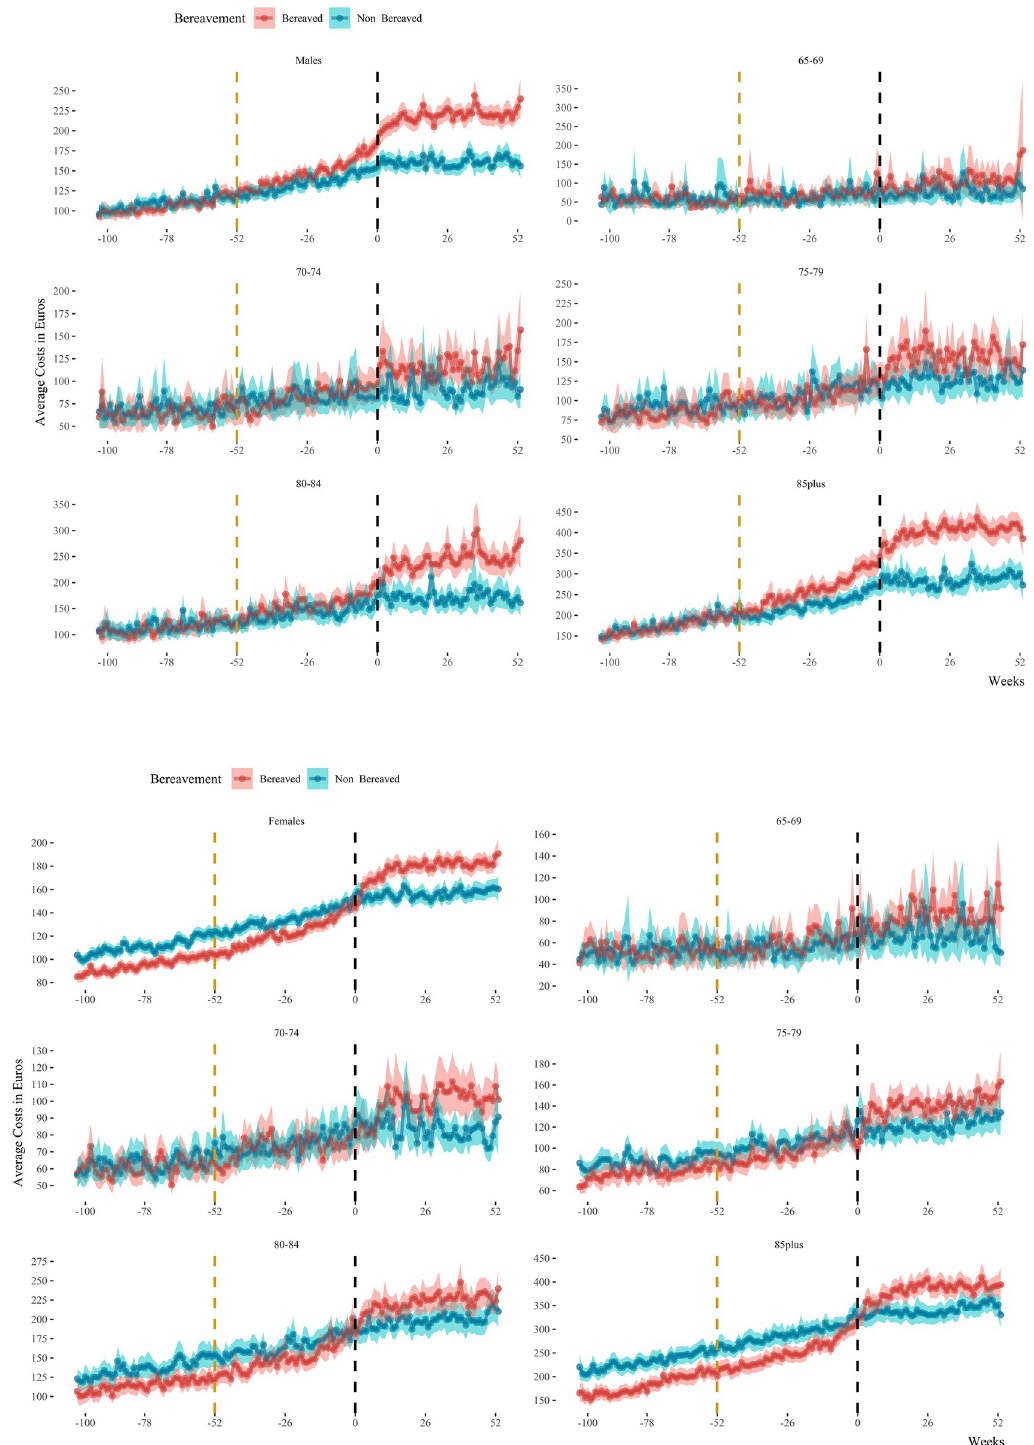
Fig 2. a . Overall average health care expenditures in Euros of males stratified on bereavement status and age. The red line represents individuals who suffered bereavement, the blue lines those who did not. Week 0 depicts the date of the standardized stressor of bereavement. Week -52 depicts the year before bereavement (yellow vertical line). The panel on the top left displays the time series of health care expenditures for males of all ages. The other panels show expenditures in various age strata. b. Overall average health care expenditures in Euros of females stratified on bereavement status and age. The red line represents